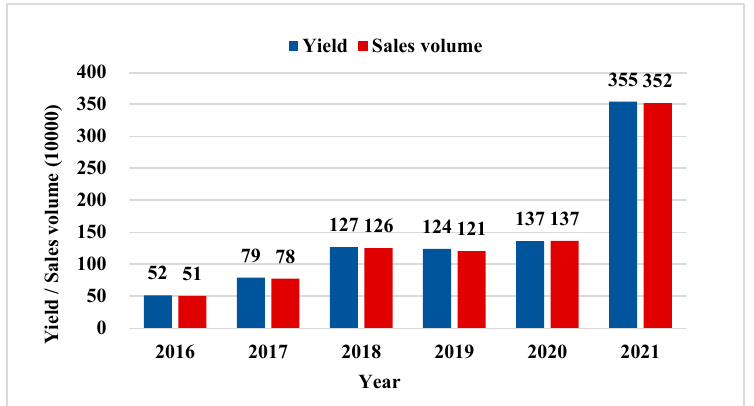
Figure 2. Production/Sales statistics of new energy vehicles in China from 2016 to 2021.